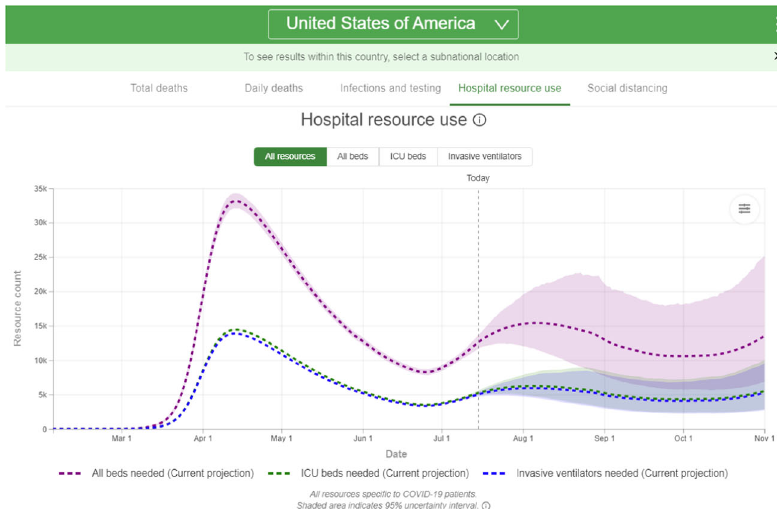
Fig. 2 Example of projected hospital resource use for COVID-19 patients in the USA using traditional modeling approaches. The image shows forecasts for use of hospital beds, intensive care beds and ventilators over the next four months from the Institute for Health Metrics and Evaluation 124 . Image courtesy of the University of Washington, available under Public License and used with